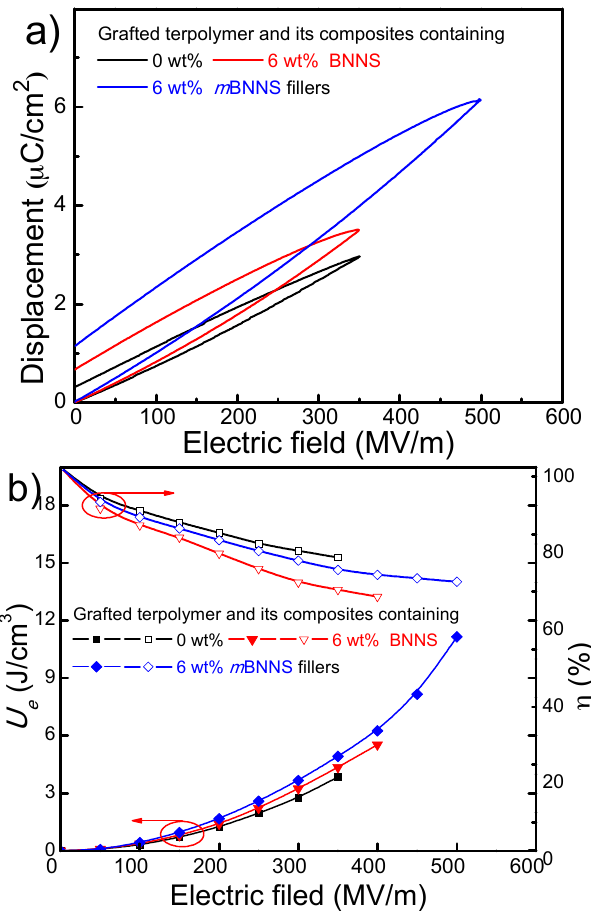
Figure 8. ( a , b ) Unipolar D-E hysteresis loops, ( c , d ) U e and η of the two composites containing 6 wt% BNNS and m BNNS particles, respectively.